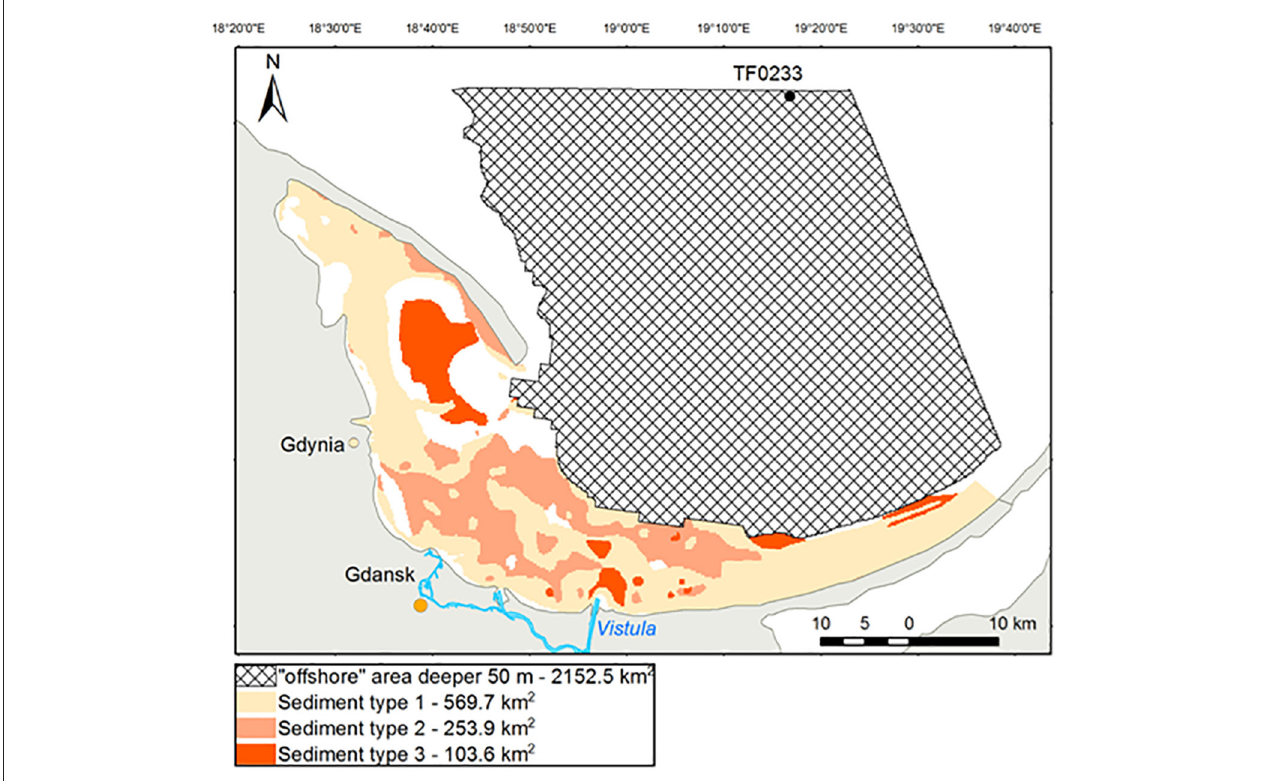
FIGURE 10 | Sediment type distribution. Type 1 = fine sand (VE04 and VE02), type 2 = medium sand (VE05, VE18, and VE49a), type 3 = mud (VE07). The shaded area indicates the offshore region (water depth of 50–100m) which were excluded from the